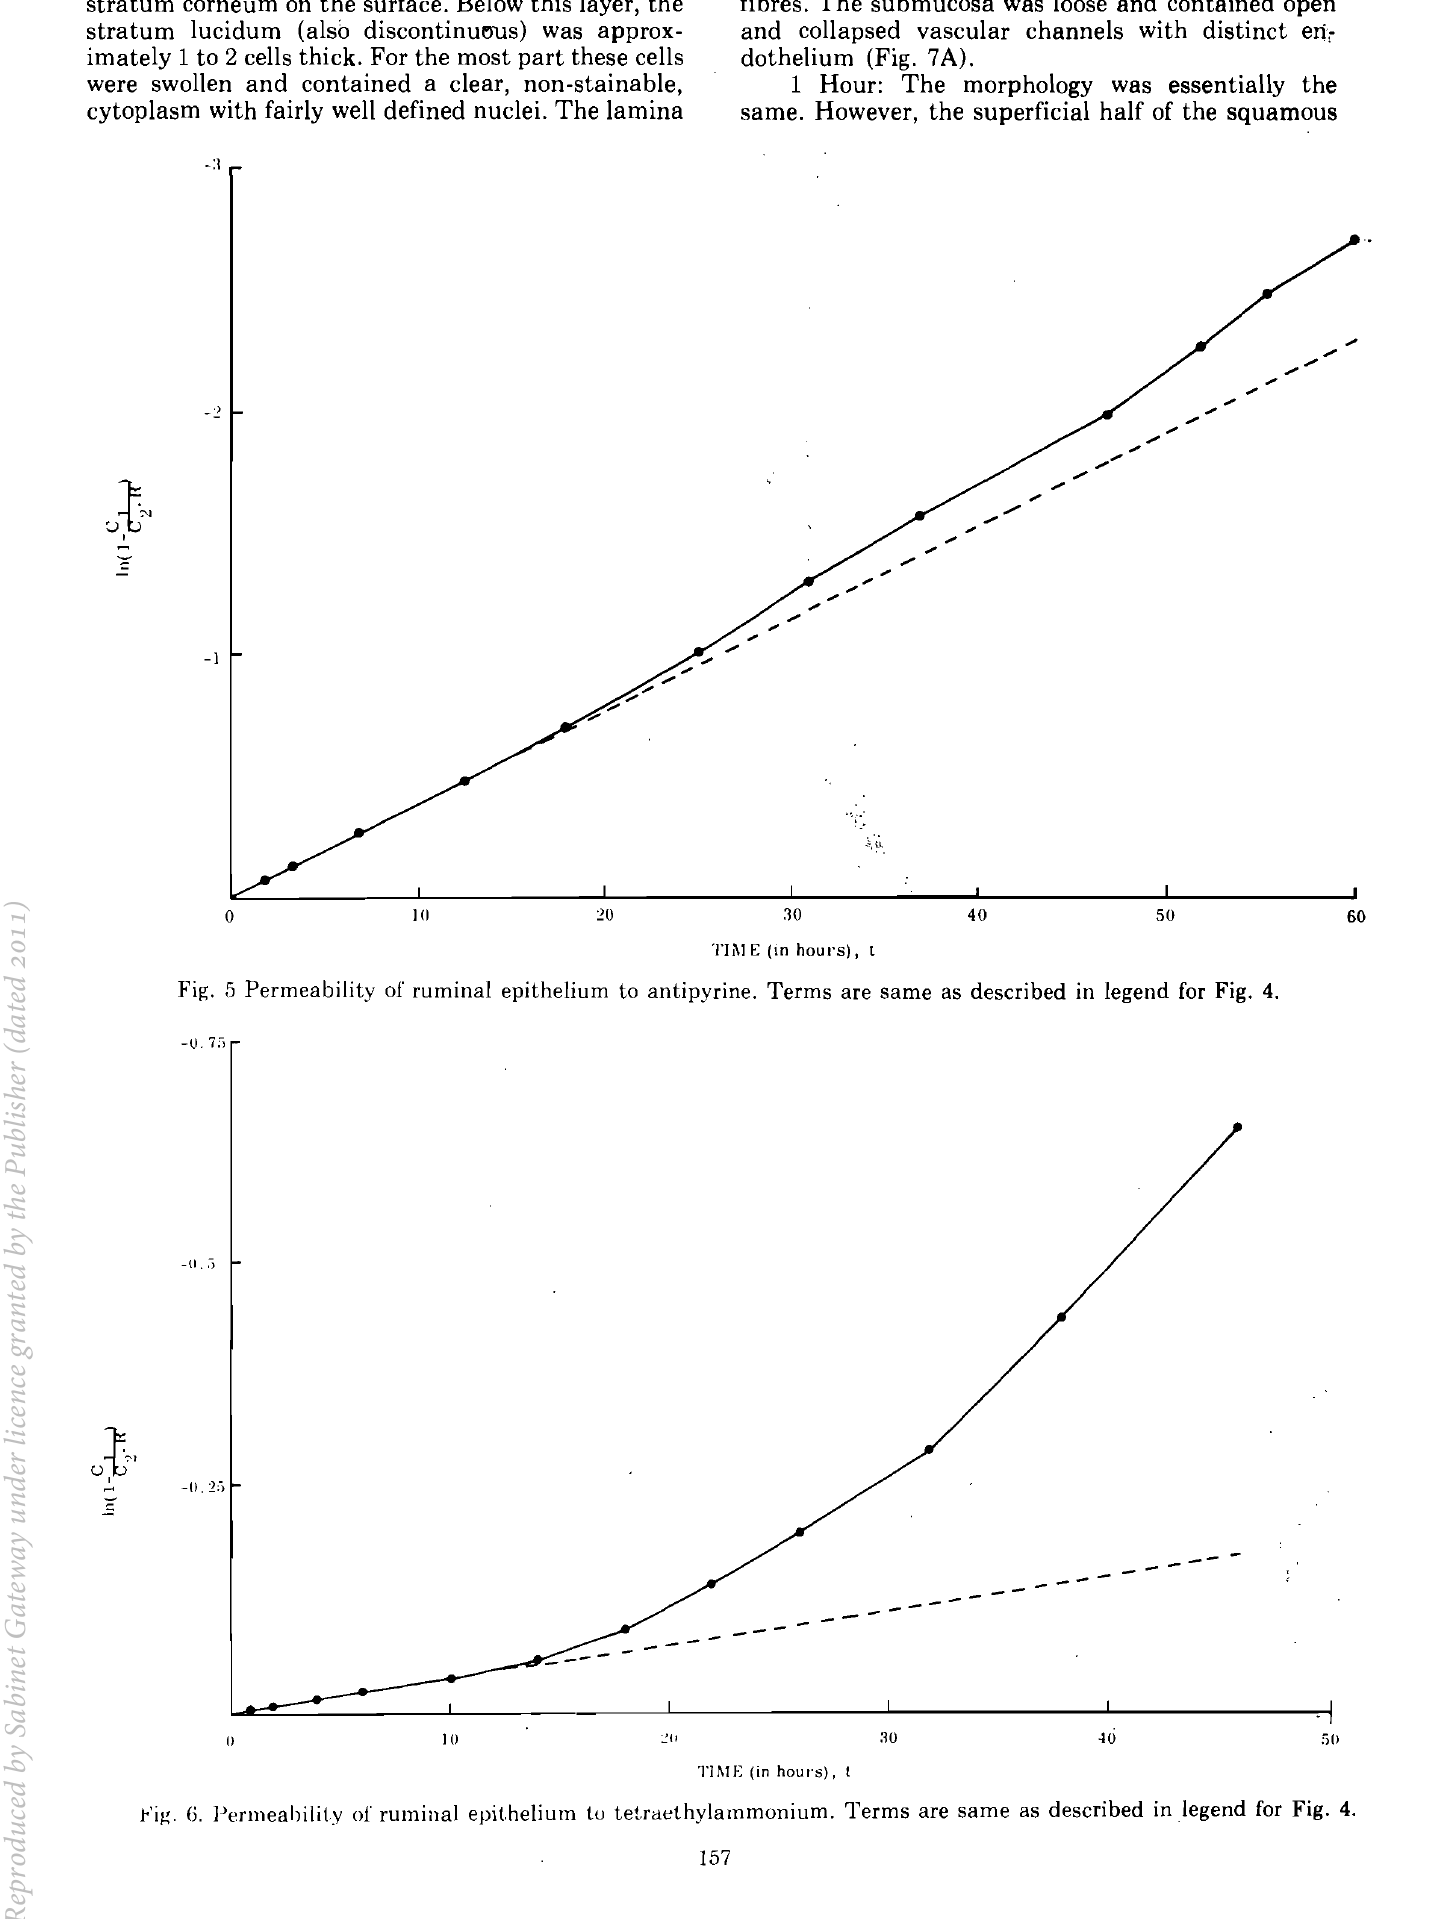
Fig .. 5 Permeability of ruminal epithelium to antipyrine. Terms are same as described in legend for Fig.